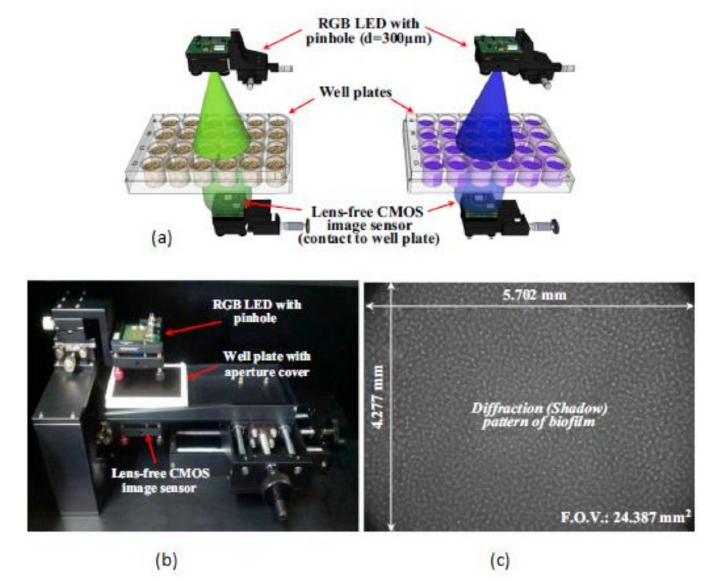
Figure 39. ( a ) RGB (Red Green Blue) LED illuminations. ( b ) Lens free CMOS image sensor-based biofilm detection. ( c ) The pattern of biofilm. Figure adapted with permission from [44], Elsevier, 2014.